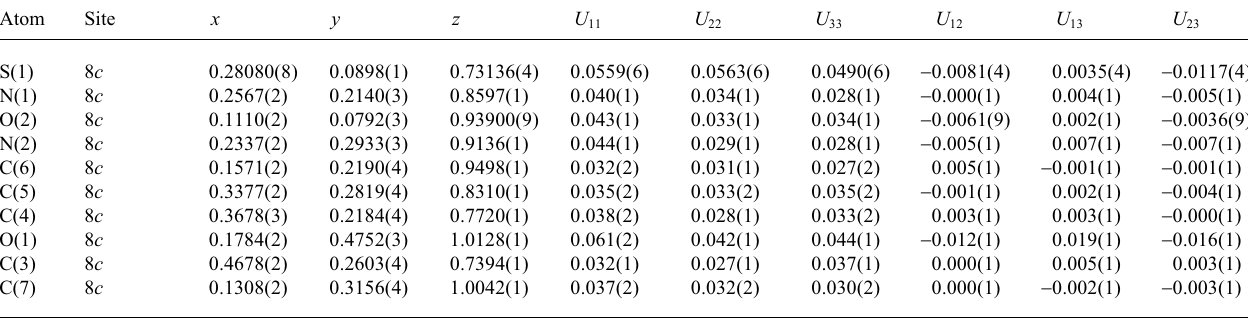
Table 3. Atomic coordinates and displacement parameters (in Å 2